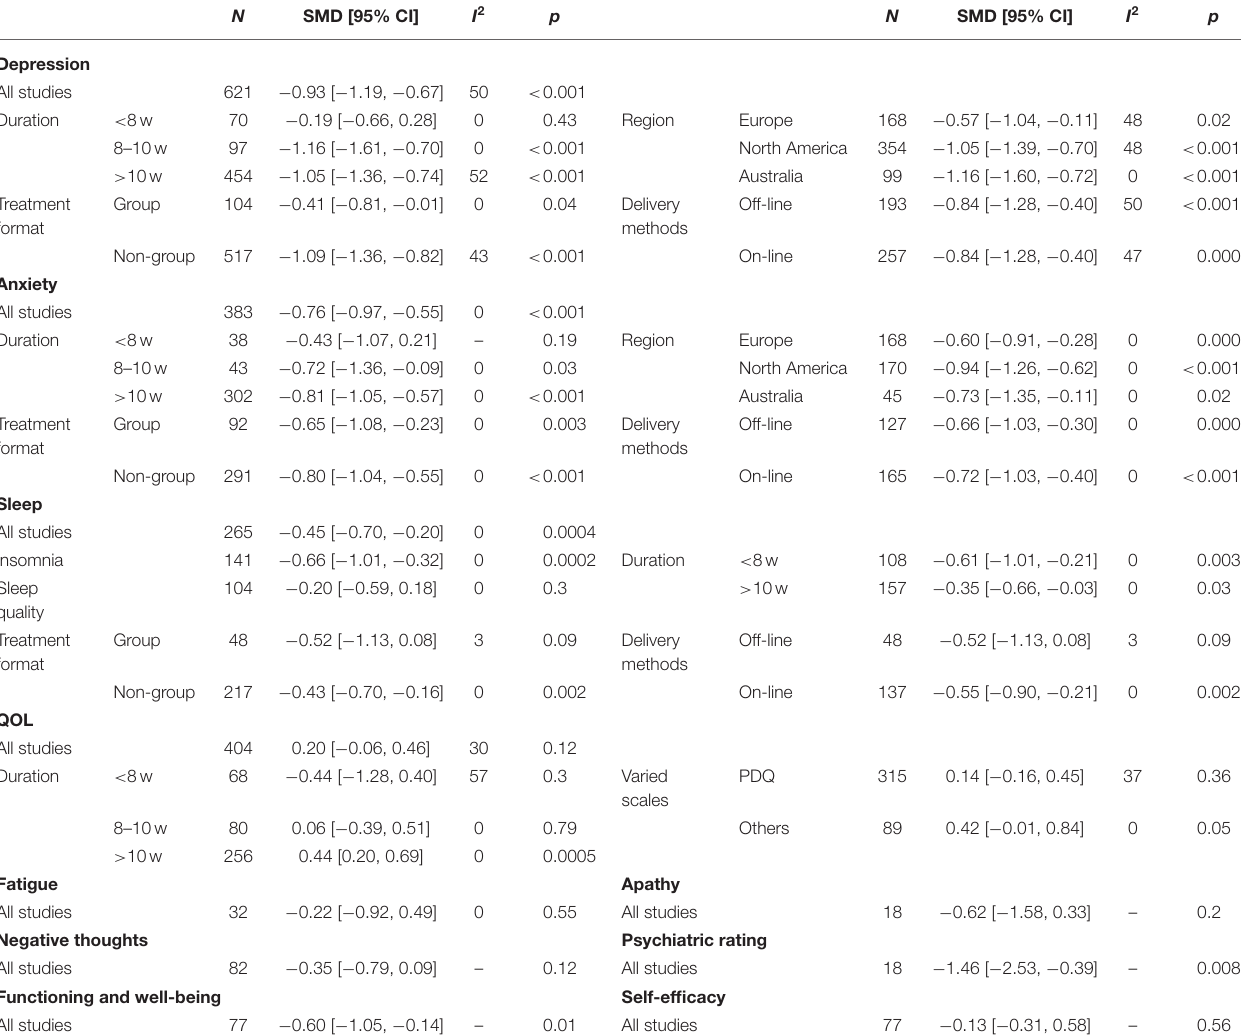
TABLE 2 | Pooled effects of CBT on the mood disorders, sleep, fatigue, and QOL in PD